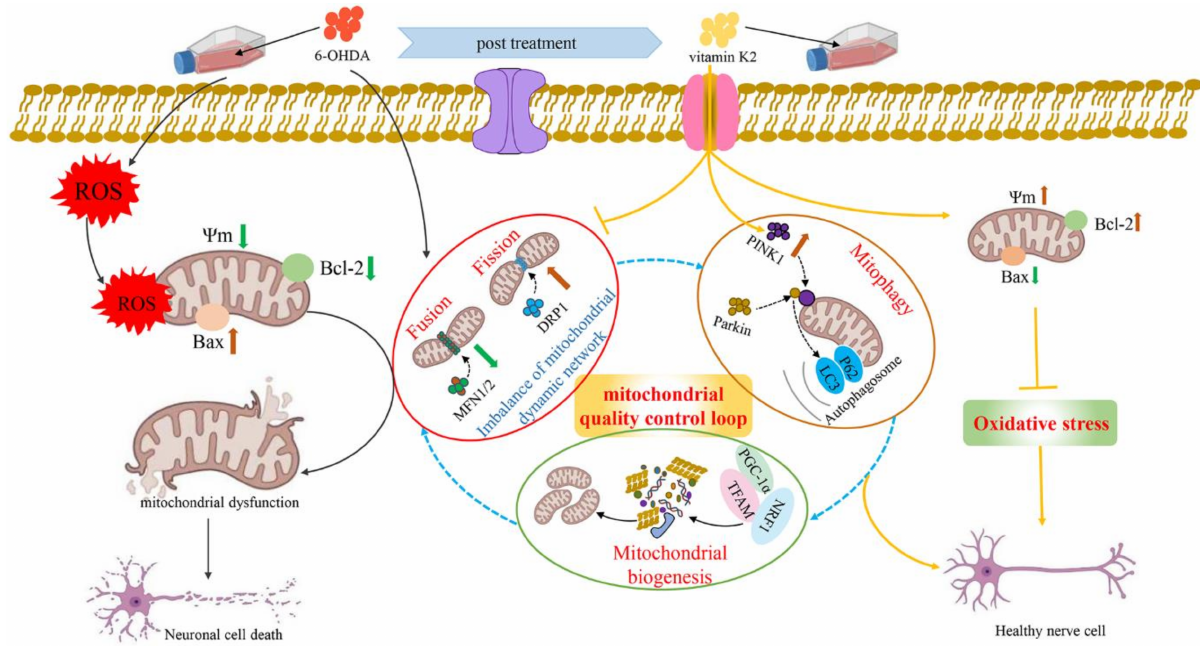
Figure 8. Schematic illustration of the protective role of vitamin K2 in 6-OHDA-induced cytotoxicity in SH-SY5Y cells. The 6-OHDA triggered ROS, causing oxidative stress in SH-SY5Y cells, which leads to mitochondrial depolarization (mitochondrial membrane potential reduction) and induction of mitochondria-mediated apoptosis, resulting in neuronal cell death. However, post-treatment with vitamin K2 maintains the balance of mitochondrial fission/fusion through the expression of regulatory proteins MFN1/2 and DRP1; promotes mitophagy by recruiting autophagy molecules p62 and LC3 through the PINK1/Parkin signaling pathway; and promotes mitochondrial